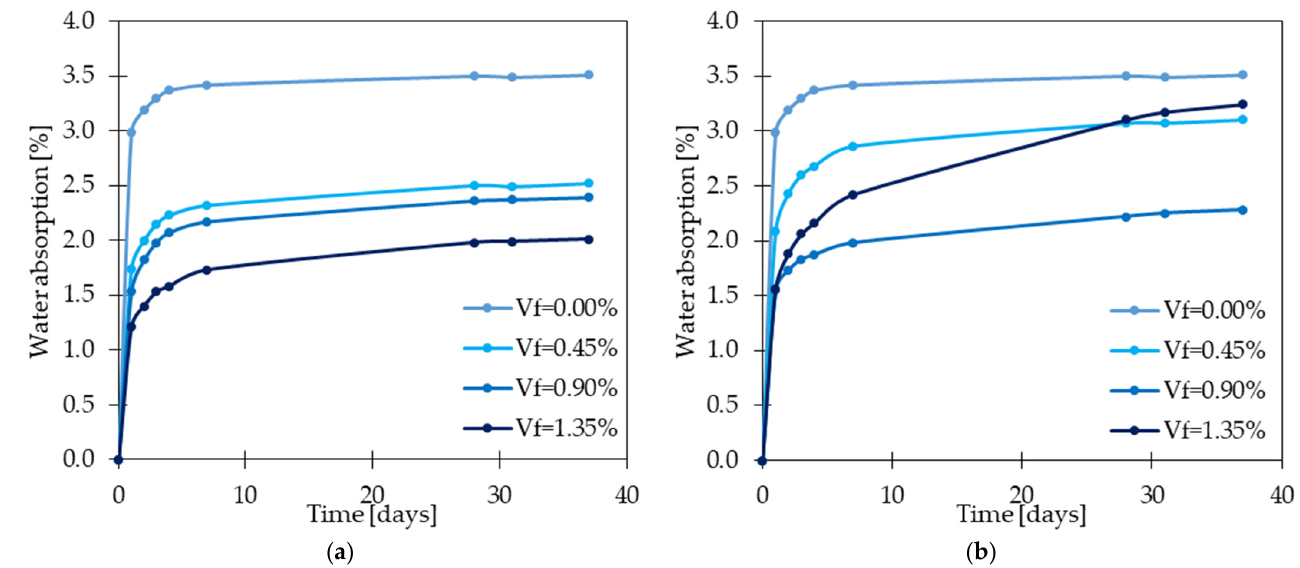
Figure 24. Water absorption of GFRC: ( a ) w/b = 0.30; ( b ) w/b = 0.35 [23].